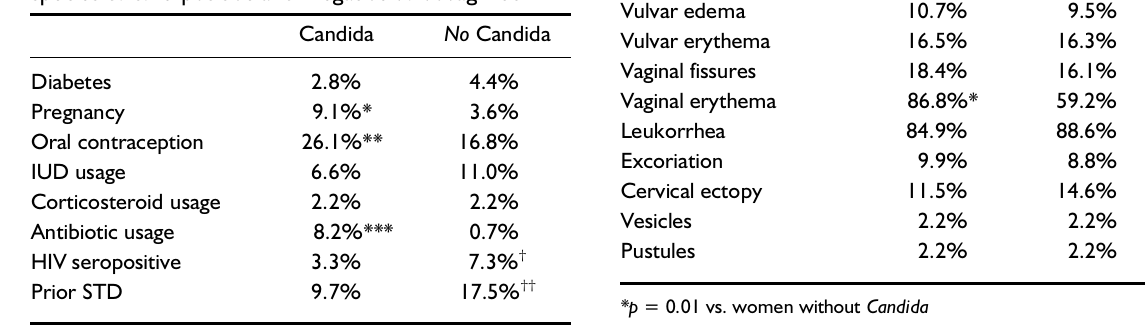
Table 3 Predisposing factors associated with Candida species culture-positive and -negative vulvovaginitis